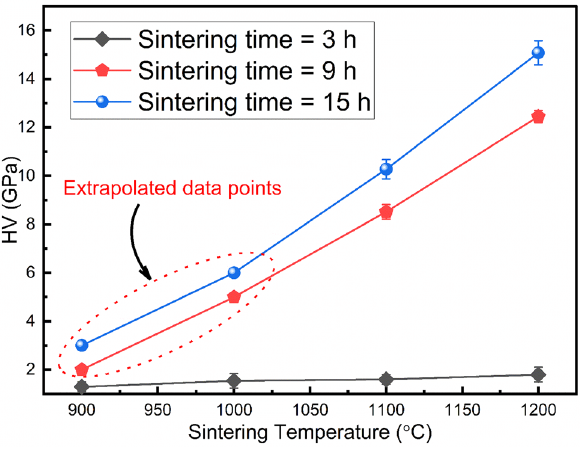
Table 2 Sintered densities of pellets of the HEOs at different sintering temperatures and times